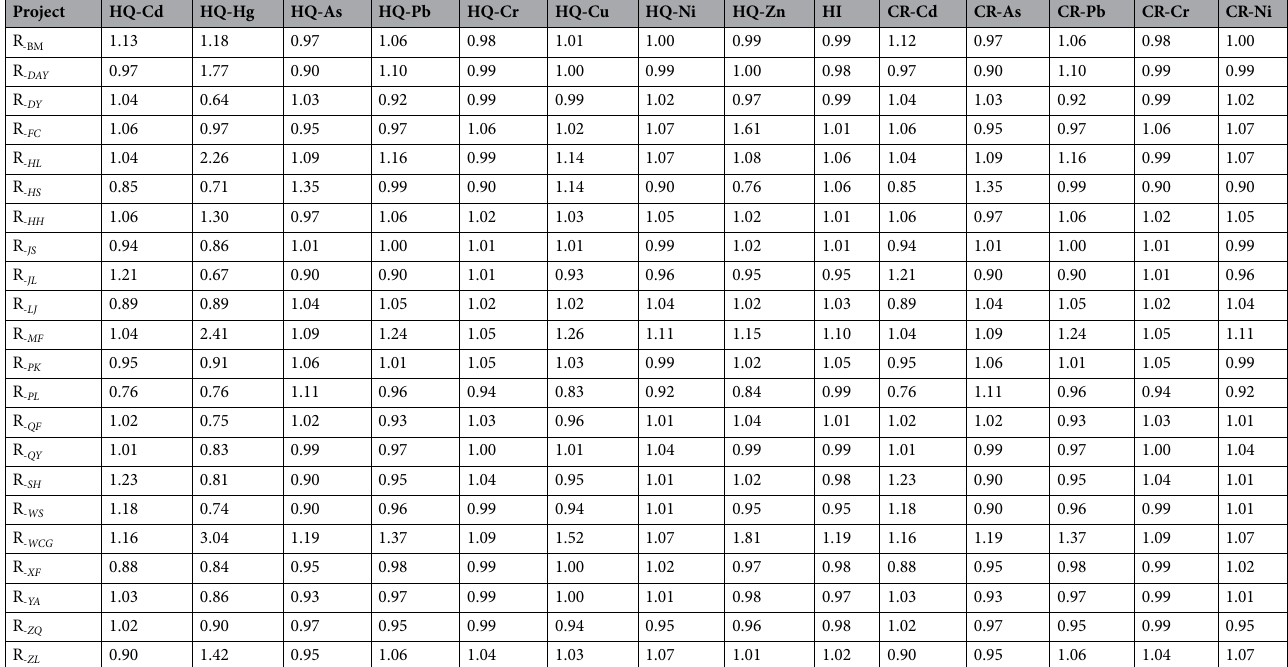
Table 5. Human health risk level of HMs in sub aera soil based on the optimized rank-scale theory